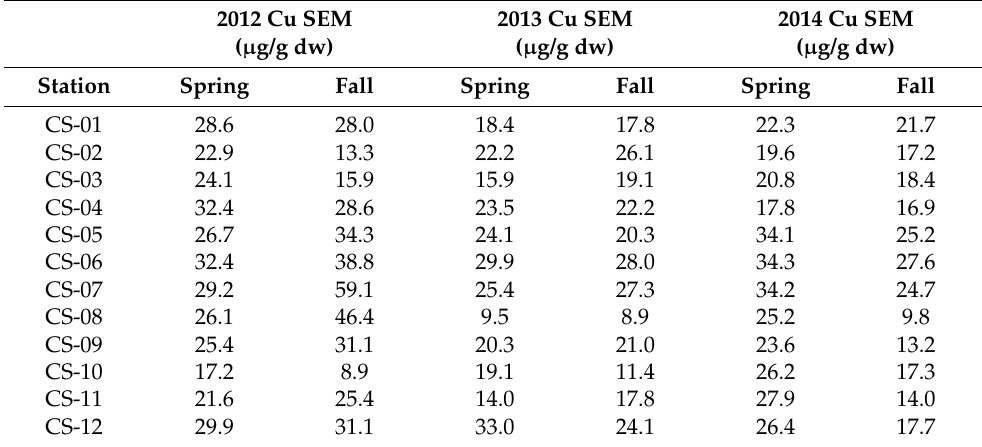
Table 1. All Cache Slough sediment copper SEM concentrations ( µ g/g dry weight) from California sampling by boat for the years 2012–2014.